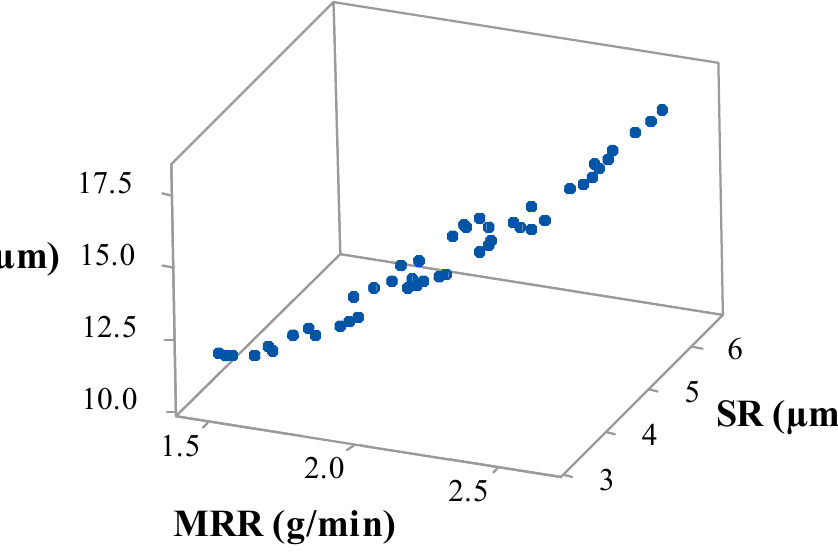
Figure 9. Pareto plot of MRR vs SR vs RLT.